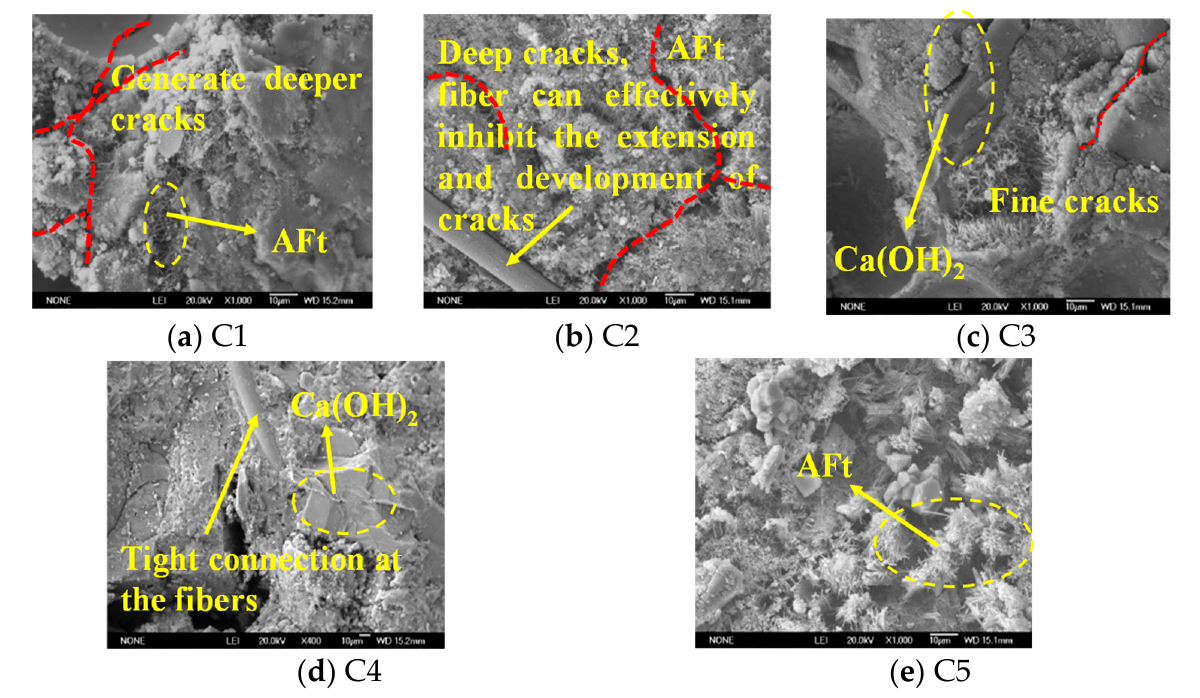
Figure 4. Microscopic morphology of concrete after corrosion.